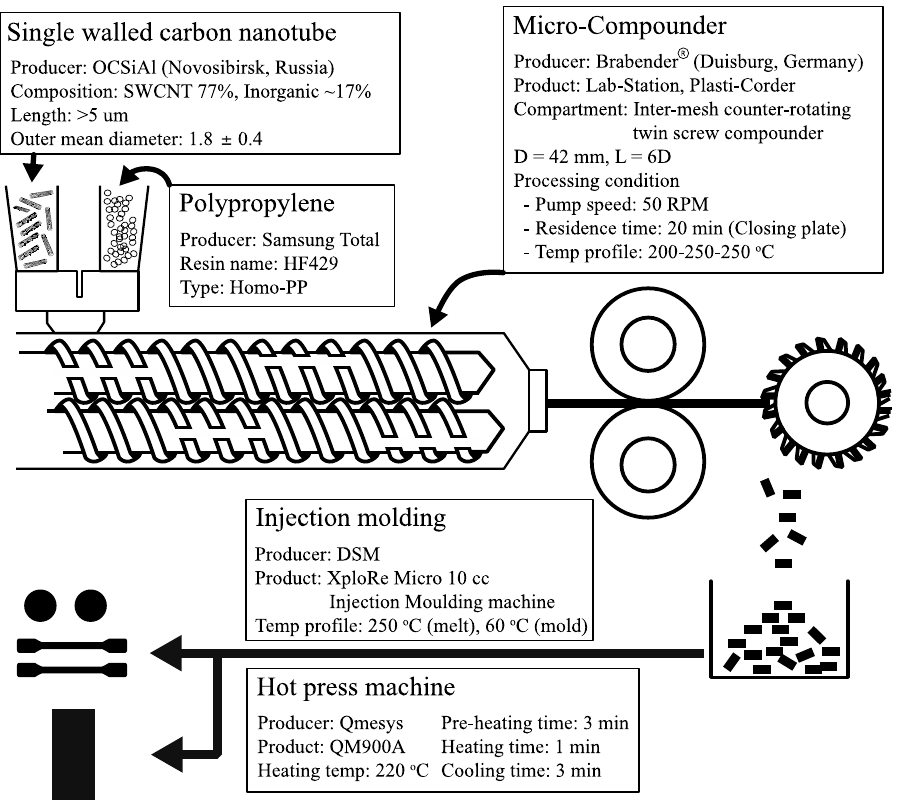
Figure 1. Schematic diagram of the sample preparation of the PP/SWNT composite for this study. In order to estimate the shear stress of the composite melt inside the barrel, the specific mechanical energy (SME) was calculated using Equation (1), where the drive torque τ (kJ), rotation speed N (min − 1 ), and throughput m (kg/min) are involved. This parameter is considered to explain the good characterization of the extrusion process.